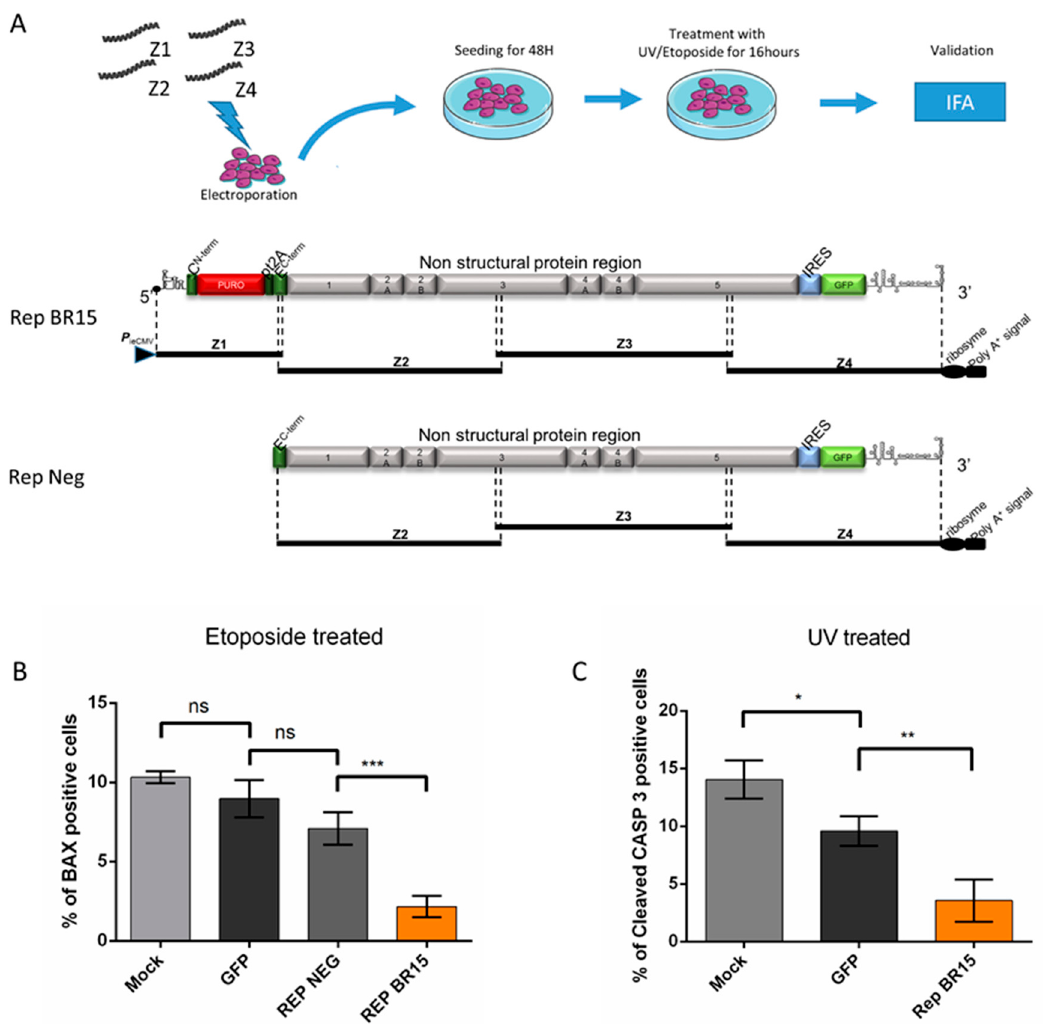
Figure 7. A549 cells transiently expressing a ZIKV replicon are protected against cell death by apoptosis. A549 cells were transfected with ZIKV amplicons (Z genomic overlapping fragments) for production of REP BR15 (Z1, 2, 3 and 4) and REP NEG (Z2, 3 and 4) or with pEGFP-N1 ( A ). At 48 h after transfection A549 cells were treated with etoposide for 16 h ( B ) or UV at 400 mJ ( C ). The percentage of A549 cells immunostained with anti-BAX antibody or anti-cleaved CASP 3 was monitored. Values represent the mean and standard deviation of three independent experiments. Data were analyzed by a one-way ANOVA test with post-hoc Tukey’s test (* p < 0.05; ** p < 0.01; ***